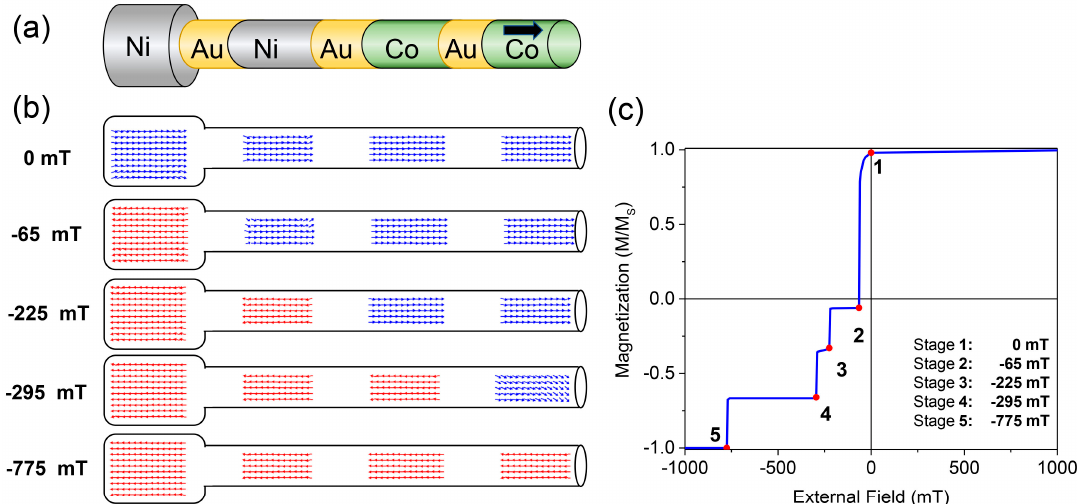
Figure 1. ( a ) Schematic representation of the nanowire with the four di ff erent segments. From left to right: Ni with larger diameter, Ni with smaller diameter, Co without magetocrystalline anisotropy and Co with magetocrystalline anisotropy. ( b ) Di ff erent stages of the magnetic simulation during the demagnetization process. ( c ) Hysteresis loop of the magnetic simulation. Red dots indicate the stages showed in ( b ).